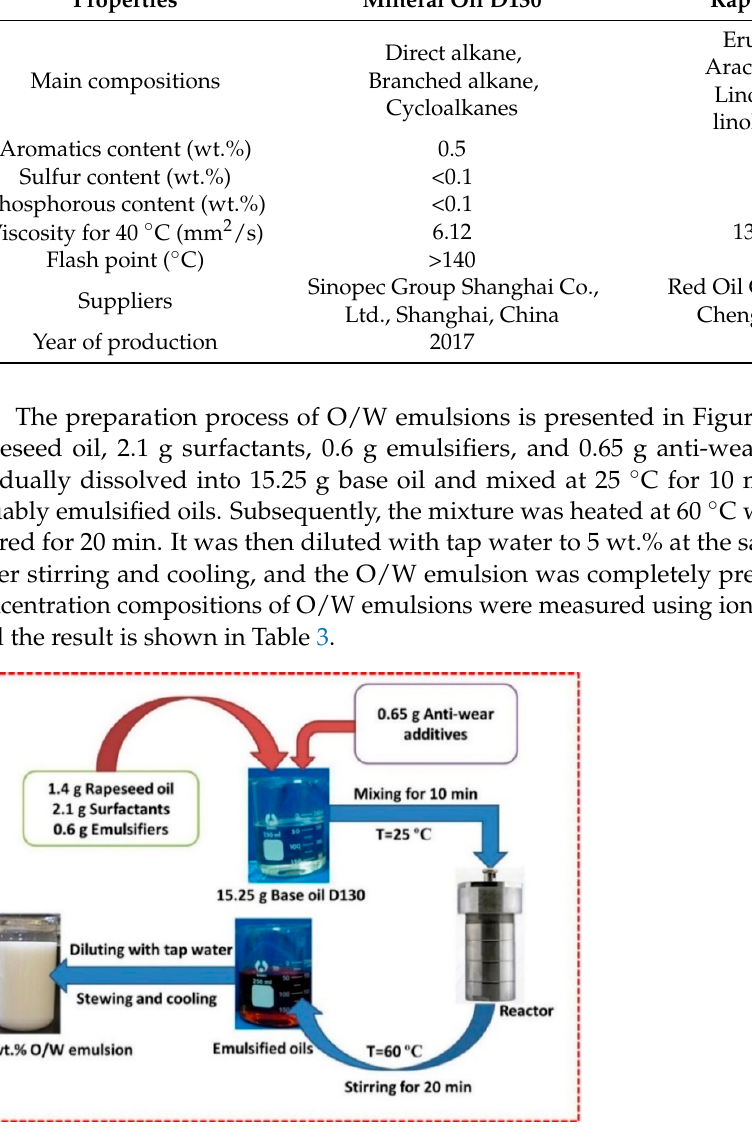
Figure 1. Preparation process of O/W emulsion. Table 3. Ionic concentration of the prepared O/W emulsion.